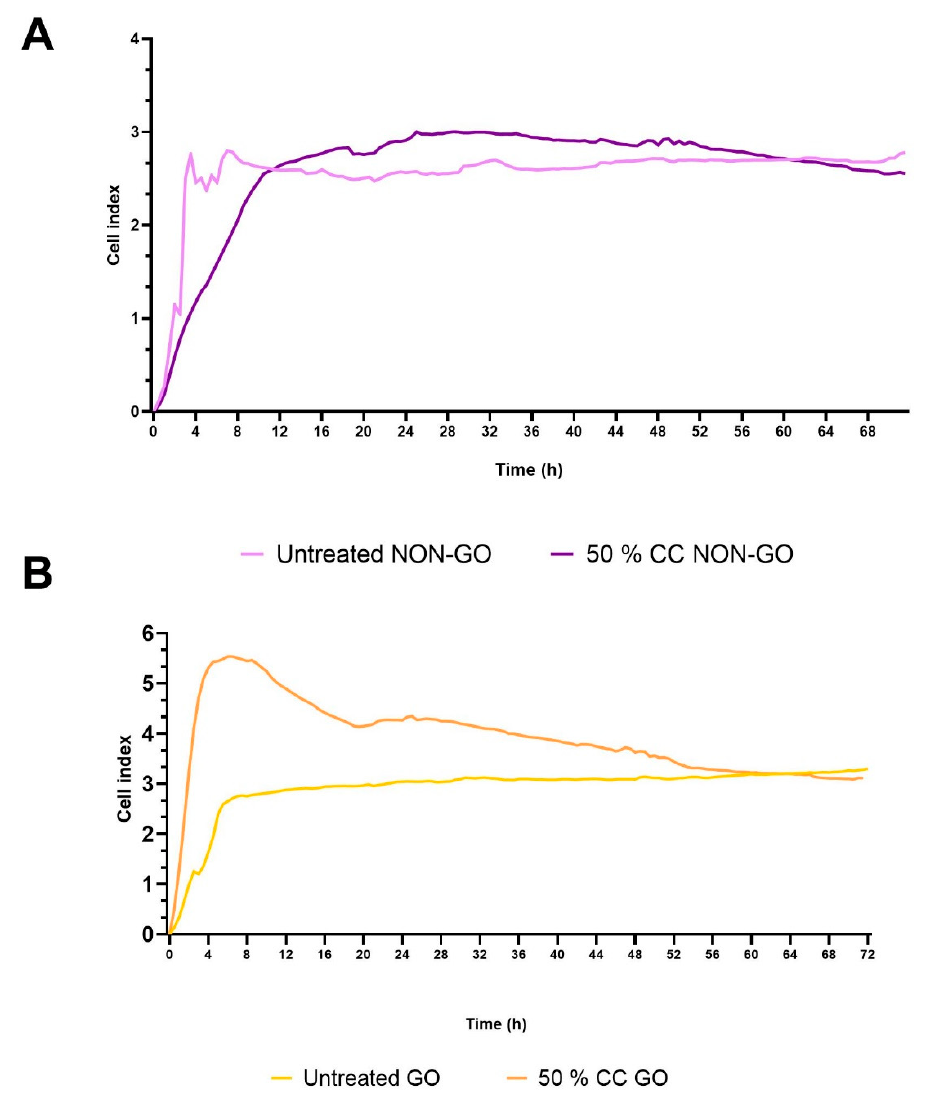
Figure 3. The effect of 50% conventional cigarette extract on the cell index using RT-CES. ( A ) NON- GO OF, ( B ) GO OF cells treated with a high concentration (50%) of CC showed an increase in the CI of GO cells but not in NON-GO cells, compared with the untreated cells. All experiments were performed in triplicates.